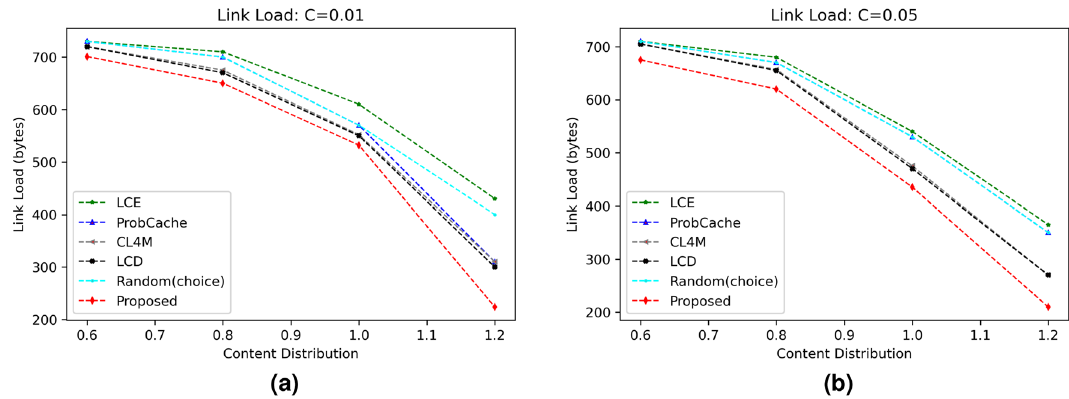
Figure 8. Influence of content distribution (α) on link